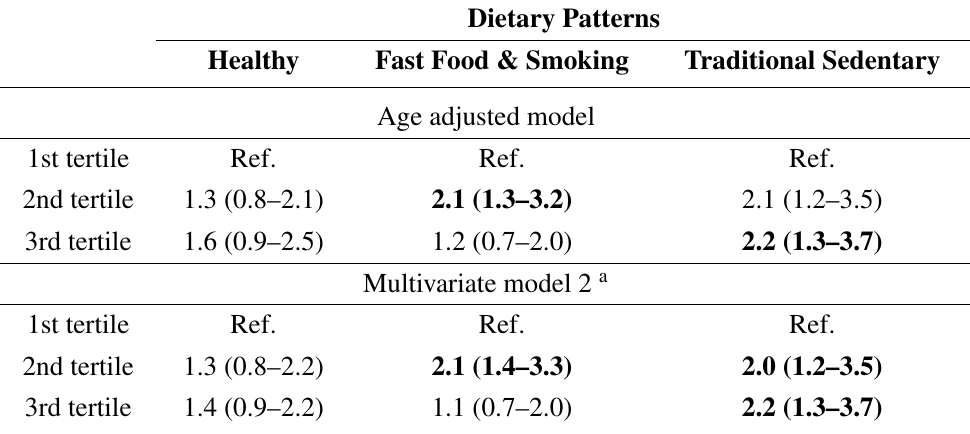
Table 4. Weighted odds ratio and their 95% Confidence Interval (CI) for the association of the identified lifestyle patterns with elevated blood pressure in the study population ( n =